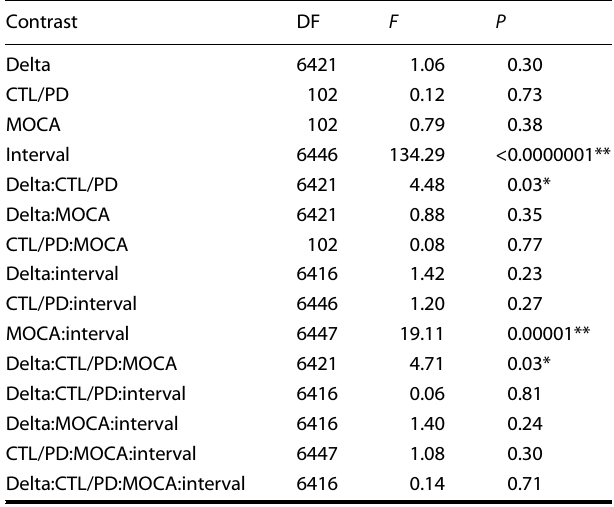
Table 1. Linear mixed-effect model of interval, disease, delta activity, and cognitive function on keypress ( R 2 = 0.46).